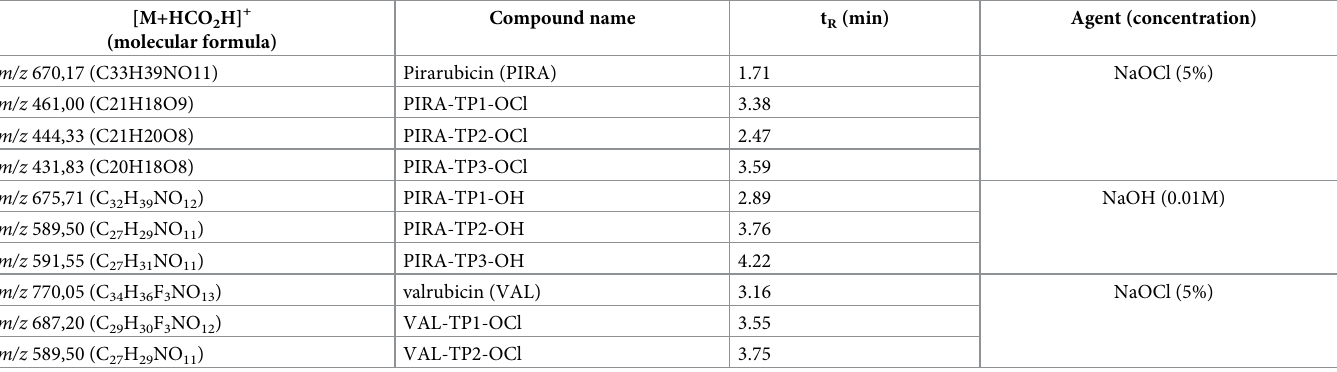
Table 2. Summary of LC-MS data, together with the molecular formula of cytostatics and transformation products (TPs). [M+HCO 2 H] + (molecular